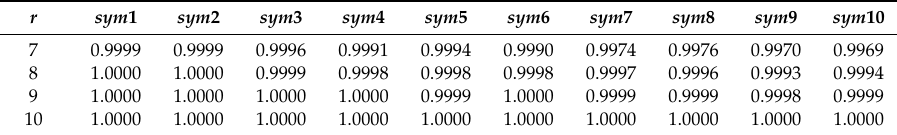
Table 24. Experimental results ( SSIM ) of 3D tomographic 16-bit image “Body_1.0” DWT by using bit-width r of symlets filters coe ffi